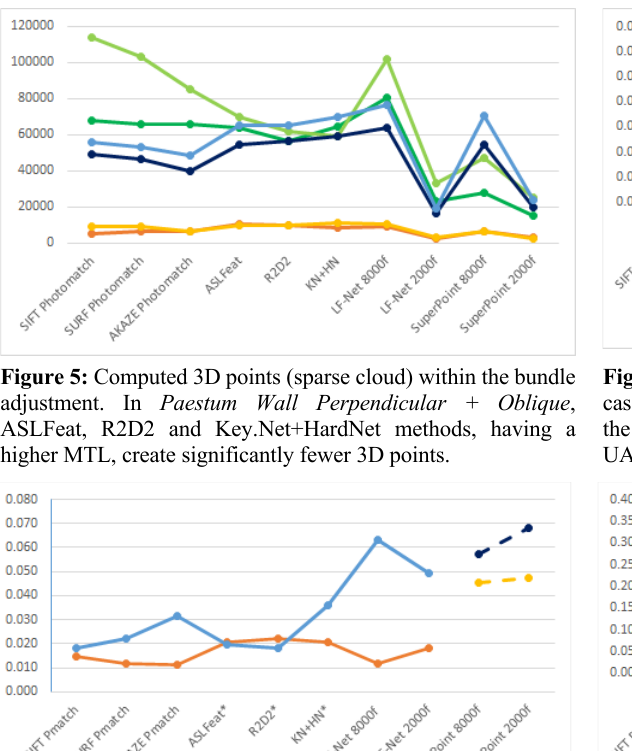
Figure 7: RMSE [m] for the Ventimiglia Theatre dataset, with only nadir images ( Nad ) and with the inclusion of oblique images ( Nad+Ob ). The SuperPoint tests are performed with only cross-check (CC) instead of cross-check + ratio test (CC+RT).